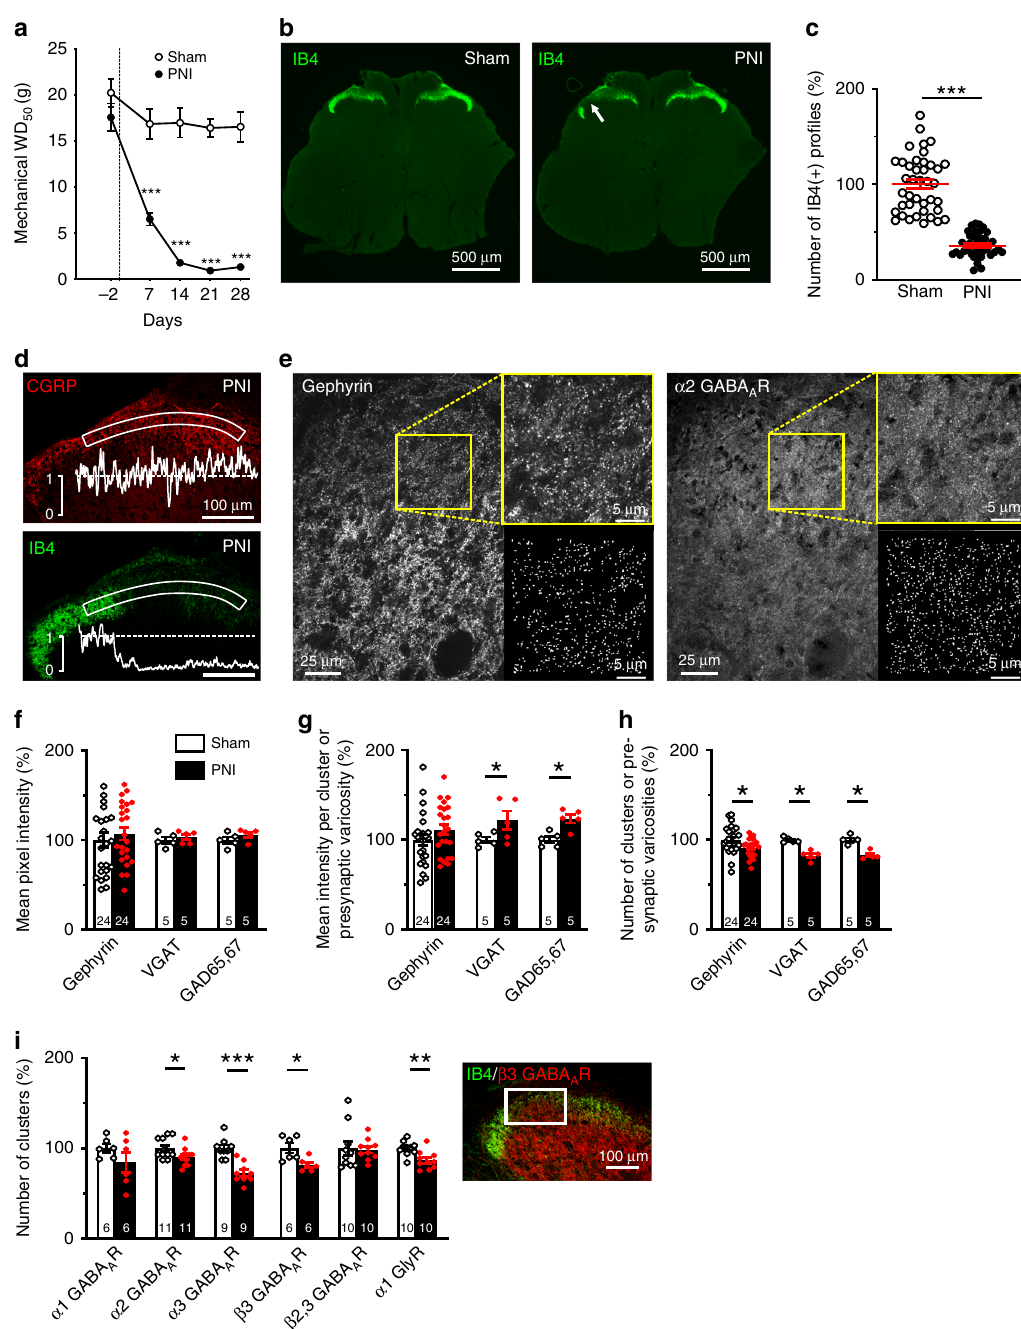
Fig. 1 Peripheral nerve injury (PNI) causes a loss of inhibitory synapses. a Time course of the change in paw withdrawal threshold (WD 50 ) to mechanical stimulation following PNI in contrast to sham operated rats ( n = 36 rats, 18 shams and 18 PNIs). In this study, all sham or PNI rats were used between day 14 and 28 post-surgery. b Loss of IB4( + ) terminals in the ipsilateral SDH (arrow). c Quanti fi cation of the number of IB4( + ) terminals in sham and PNI rats ( n = 82 rats, 40 shams and 42 PNIs). d Intensity pro fi les of IB4 and CGRP immunolabeling in the super fi cial ipsilateral SDH from PNI rats. e Example confocal images of gephyrin and α 2 GABA A R immunolabeling in the SDH to illustrate the binary mask segmentation of clusters (right insets). f – h Quanti fi cation of: the overall mean pixel intensity f , the mean intensity per cluster g , and the number of clusters h for selected inhibitory synaptic markers in the area de fi ned by the loss of IB4 labeling in PNI rats and corresponding area in sham-operated rats (Fig. 1b, d). i Quanti fi cation of the number of clusters for a subset of GABA A and glycine receptor subunits in the area de fi ned for Fig. 1f-h. Inset: example immunolabeling in the region of interest de fi ned by the loss of IB4 labeling. IB4, isolectin B4; CGRP, calcitonin gene related protein; VGAT, Vesicular GABA Transporter. GAD65,67, Glutamatic Acid Decarboxylases 65 and 67; WD 50 , 50% paw withdrawal threshold. Number in each bar represents the number of sham or PNI rats used. Error bars in all panels represent S.E.M. (* P < 0.05; ** P < 0.01; *** P < 0.001). Source data is available as a Source Data fi